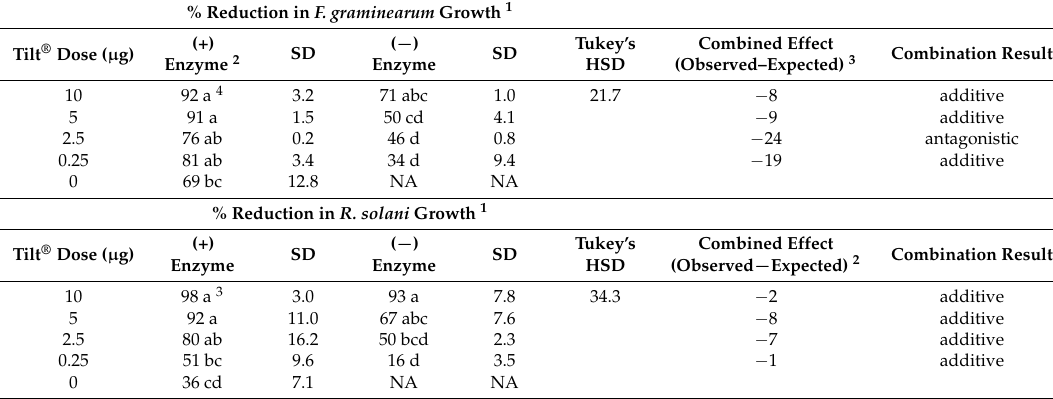
Table 5. Inhibition of Fusarium graminearum and Rhizoctonia solani by the stabilized LPO formulation alone and in combination with Tilt ® using fungicide-impregnated filter paper